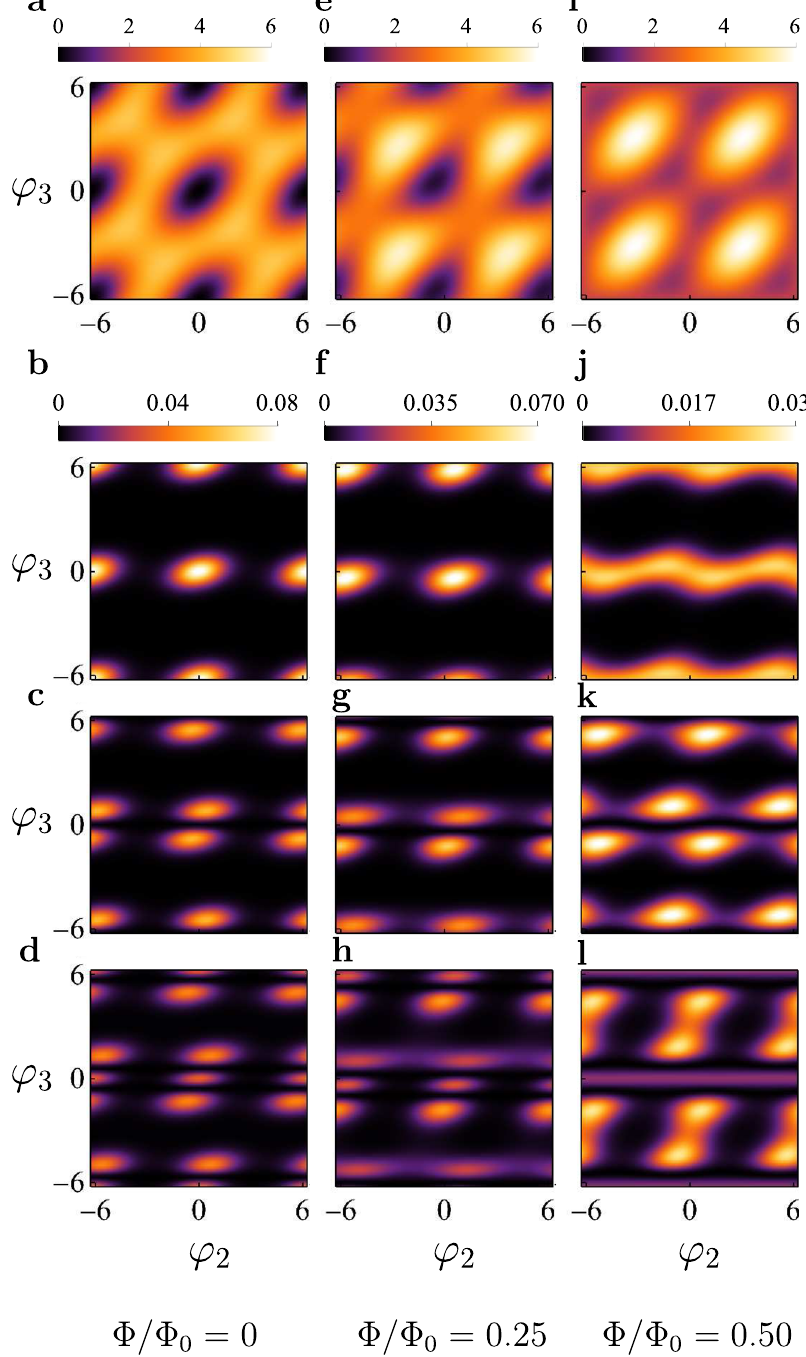
Fig. 5 Potential energy and the square of the wave functions corresponding to the fi rst three energy levels. Two dimensional potential of the fl ux qubit for three different values of the magnetic fl ux: Φ = 0 ( a ), Φ = 0.25 Φ 0 ( e ) and Φ = 0.5 Φ 0 ( i ). The squared wave functions of the ground state with n = 0 are shown in b , f , j ; of the fi rst excited level with n = 1 — in c , g , k ; and the second excited level with n = 2 — in d , h , l